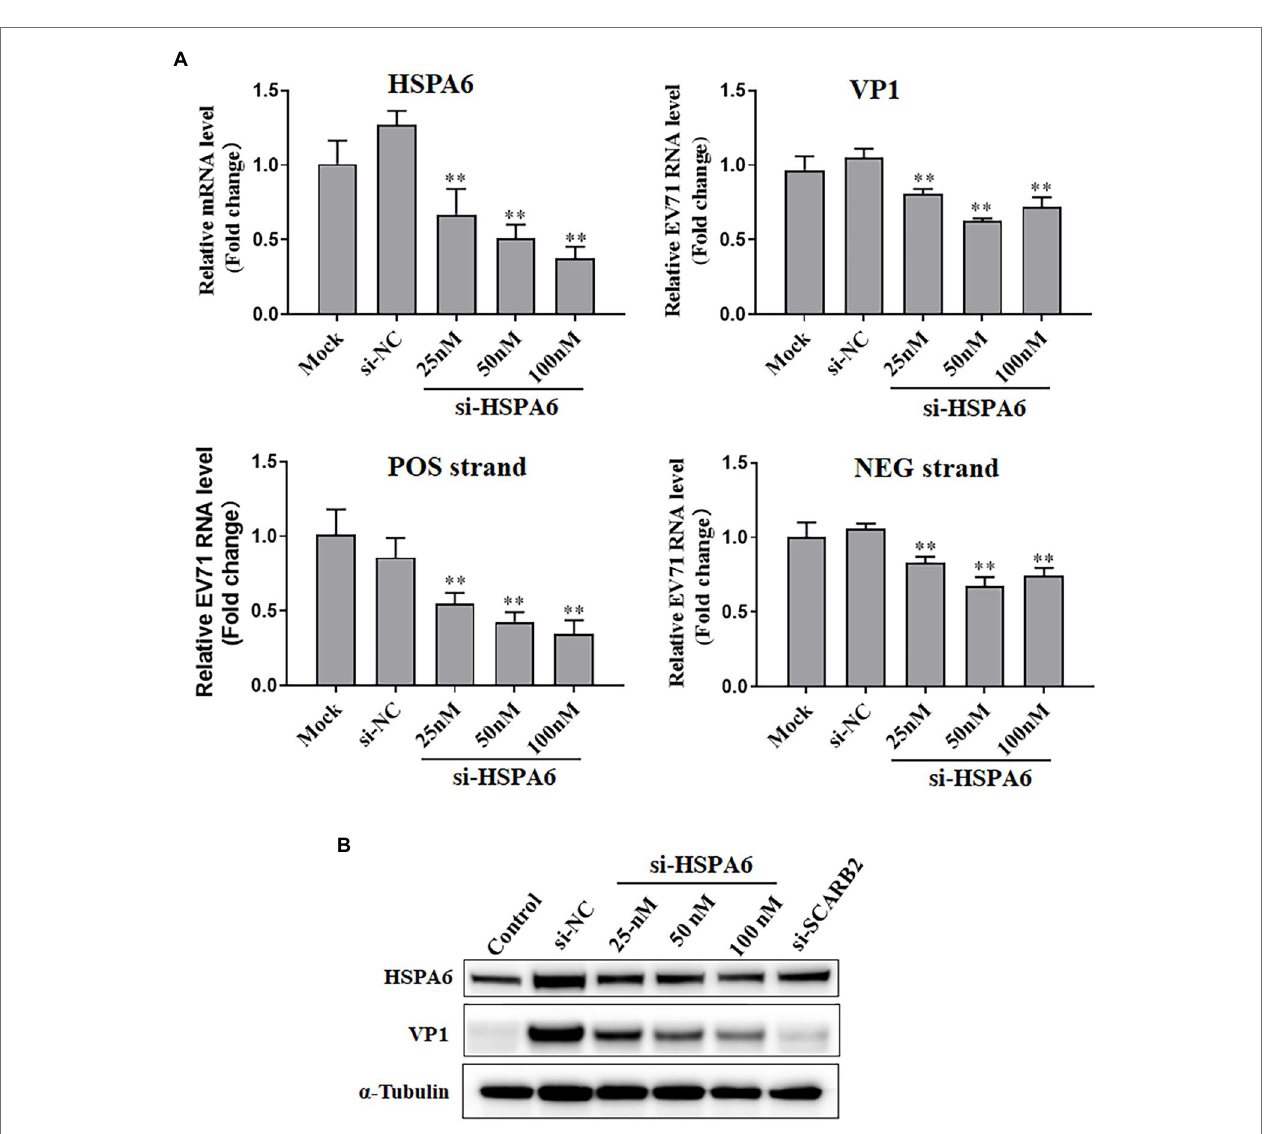
FIGURE 3 | HSPA6 knockdown inhibits EV71 replication and protein expression. (A) RT-PCR measurement of HSPA6 as well as viral VP1, positive (POS) strand, and negative (NEG) strand expression in RD cells transfected with siRNAs targeting HSPA6 (si-HSPA6) and infected with EV71. (B) Western blotting analysis of protein level of HSPA6 protein and viral VP1 in RD cells transfected with siRNAs and infected with EV71. Mock is the infected but untreated control, si-NC is the negative control siRNA targeting no known genes. Control in B is the cell control without viral infection and siRNA transfection. si-SCARB2 is siRNA targeting the receptor of EV71, using it as the positive control (vs. si-NC, ** p <